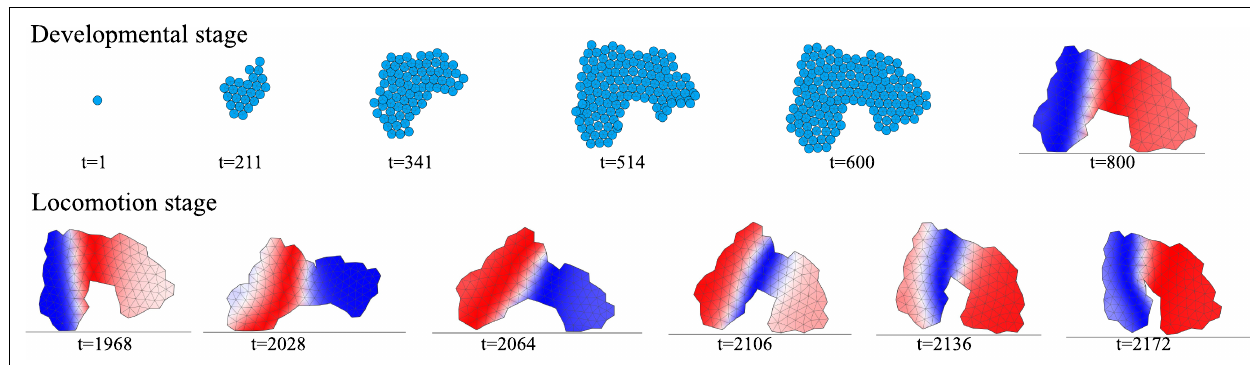
Fr ontiers in Robotics and AI |